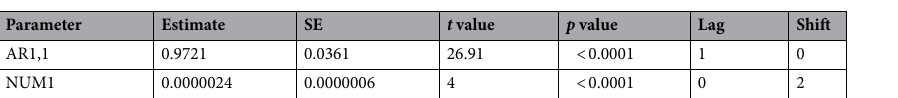
Table 1. ESBL-producing E. coli proportion and ciprofloxacin usage parameter estimates based on the transfer function model. The autoregressive parameter was labelled as AR1,1: representing past value of